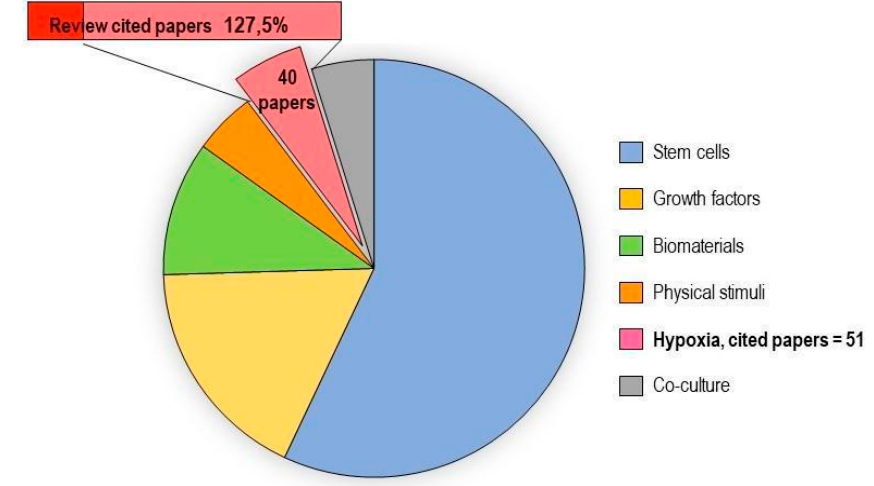
Figure 7. The pink section shows the percentage / number of papers available on Scopus database obtained by combining key words in vitro stem cells tendon differentiation with hypoxia. In the histogram, the relative percentage of cited papers is expressed as well as the relative number in the legend.